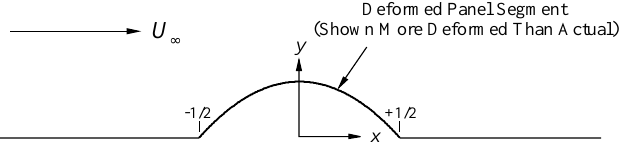
Fig. 1. Schematic of panel and coordinate